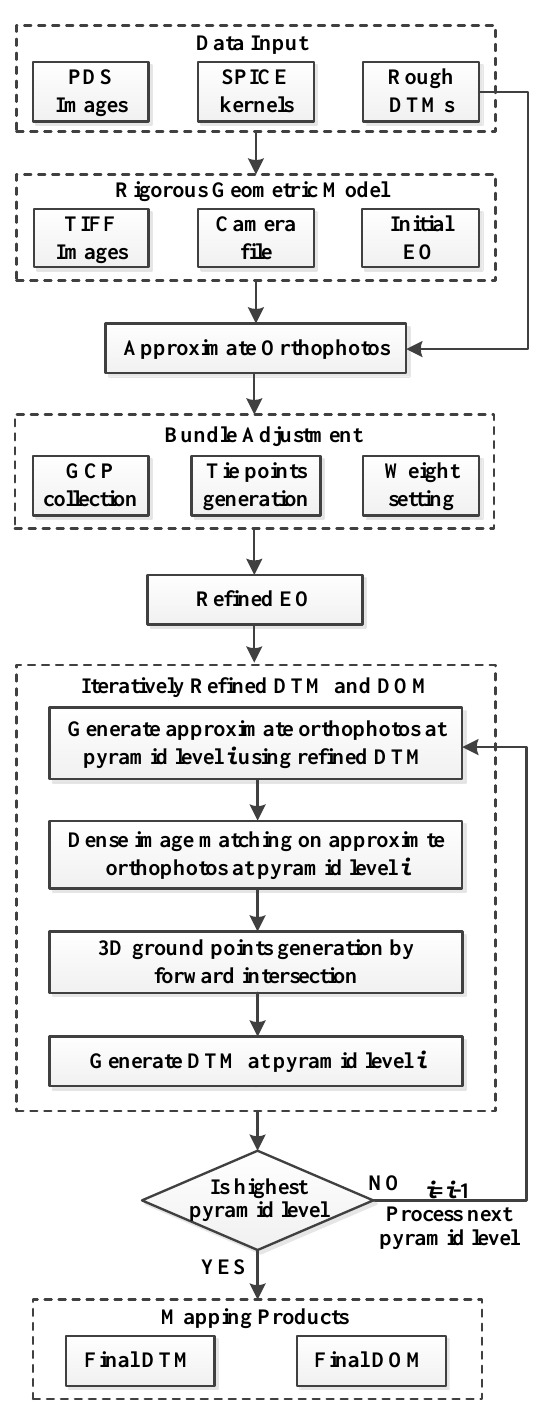
Figure 1. Flowchart of photogrammetric processing of planetary images based on approximate